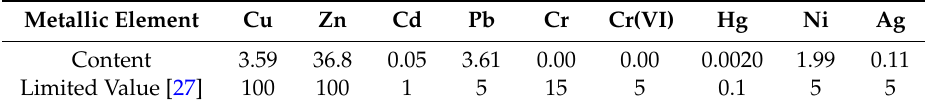
Table 3. Extraction toxicity of the leaching residue (unit in